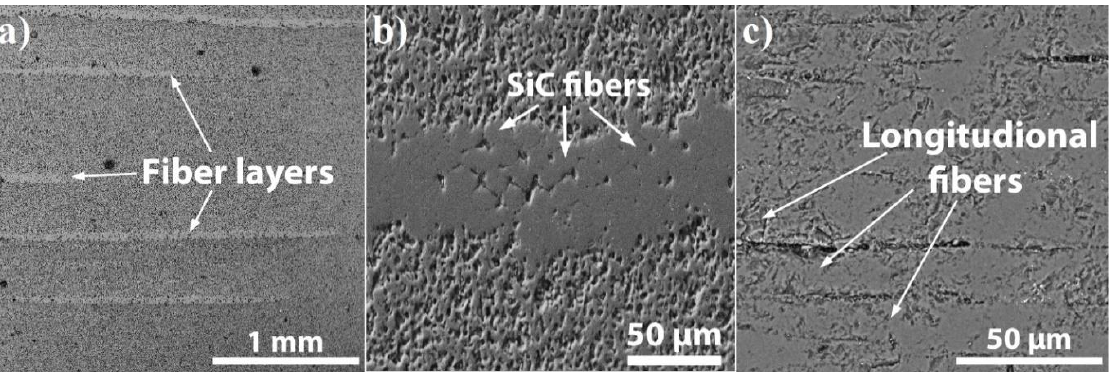
Figure 7. Scanning electron microscopy (SEM) images of SiC f / SiC p composites: fiber layers ( a ); cross-section view of SiC fibers ( b ); longitudinal fiber arrangement ( c ).